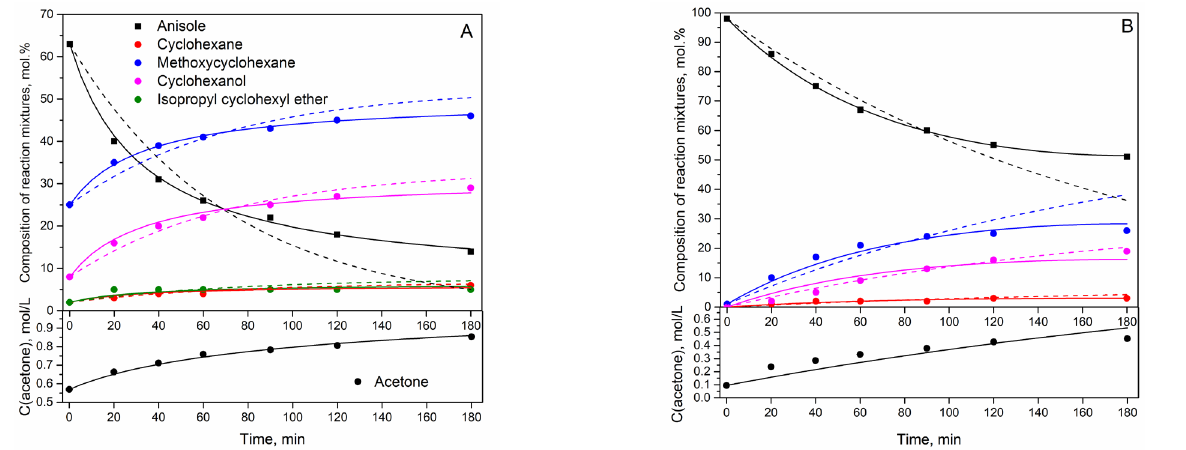
Figure 5. Percentage composition of the reaction mixtures as a function of time obtained over Ni(41)Cu(4)–SiO 2 at ( A ) 250 °C, 7.3–8.1 MPa, and ( B ) 150 °C. 0.8–1.0 MPa; m(catalyst) = 0.10–0.11 g at 250 °C and 0.36–0.37 g at 150 °C. The dots present the experimental data and the dash lines were calculated using a quasi-first-order kinetic model. Solid lines—the model taking into account the effect of acetone.